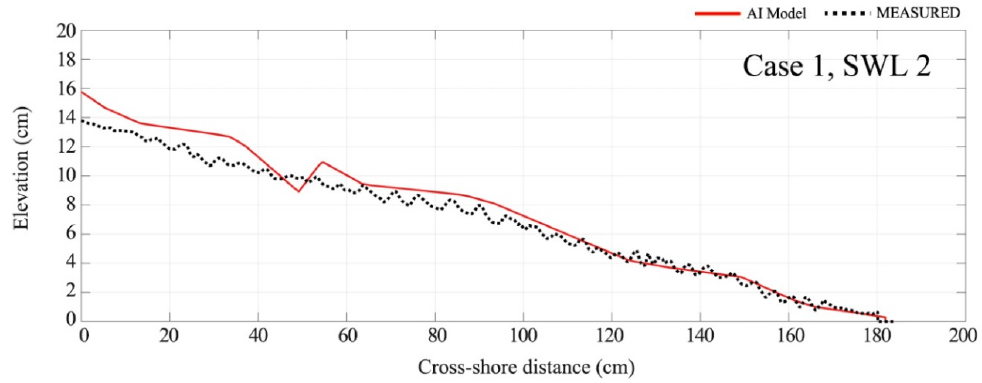
Figure 15. Case 1 SWL 2 comparison of the ANN prediction and measured from the physical test.